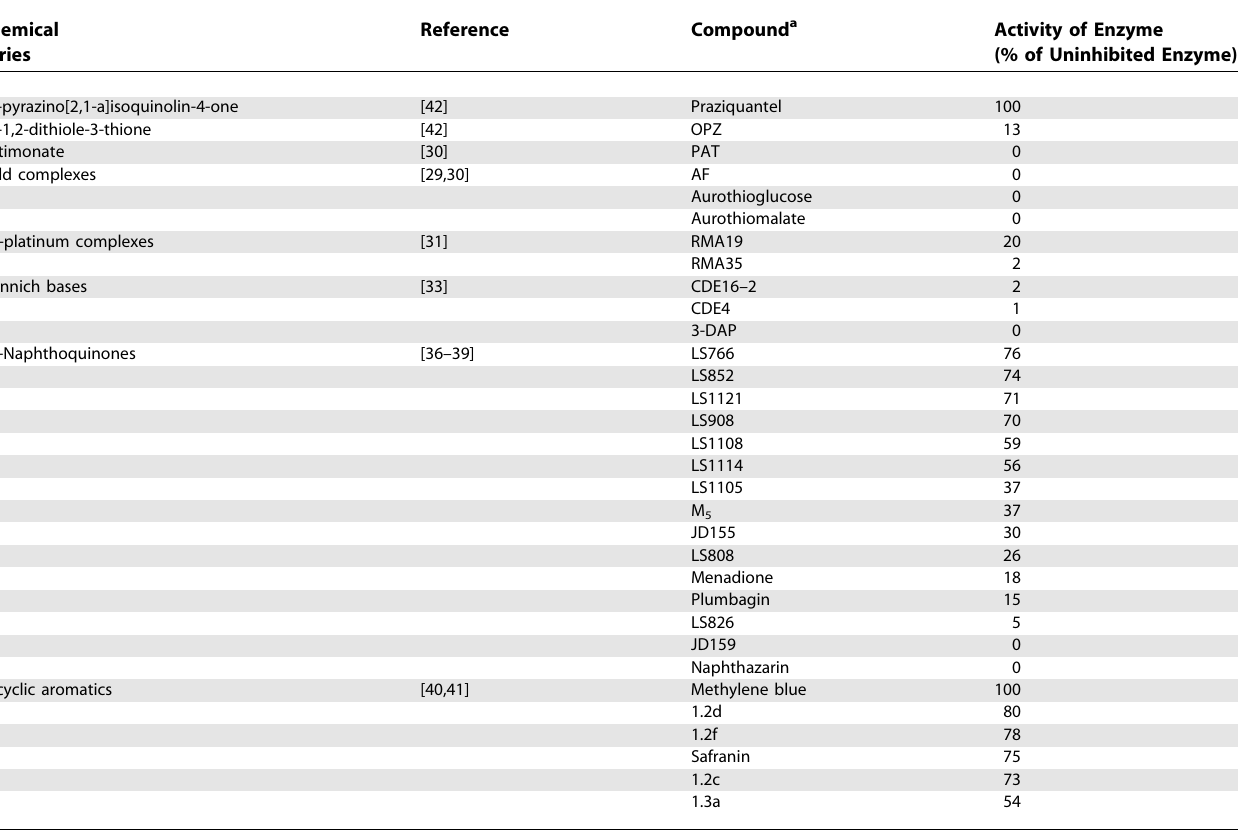
Table 3. Primary Screen of NADPH-Dependent Oxidoreductase Flavoprotein Inhibitors and Antischistosome Drugs as Inhibitors of S. mansoni TGR Chemical Series